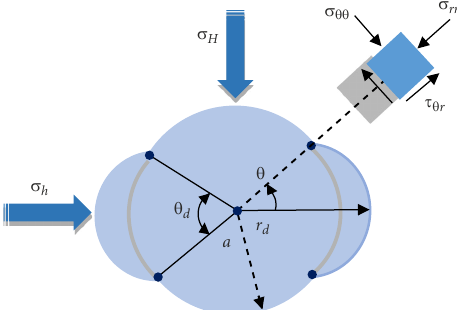
Figure 4. Schematic figure of borehole cross-section and failure zone on r – q